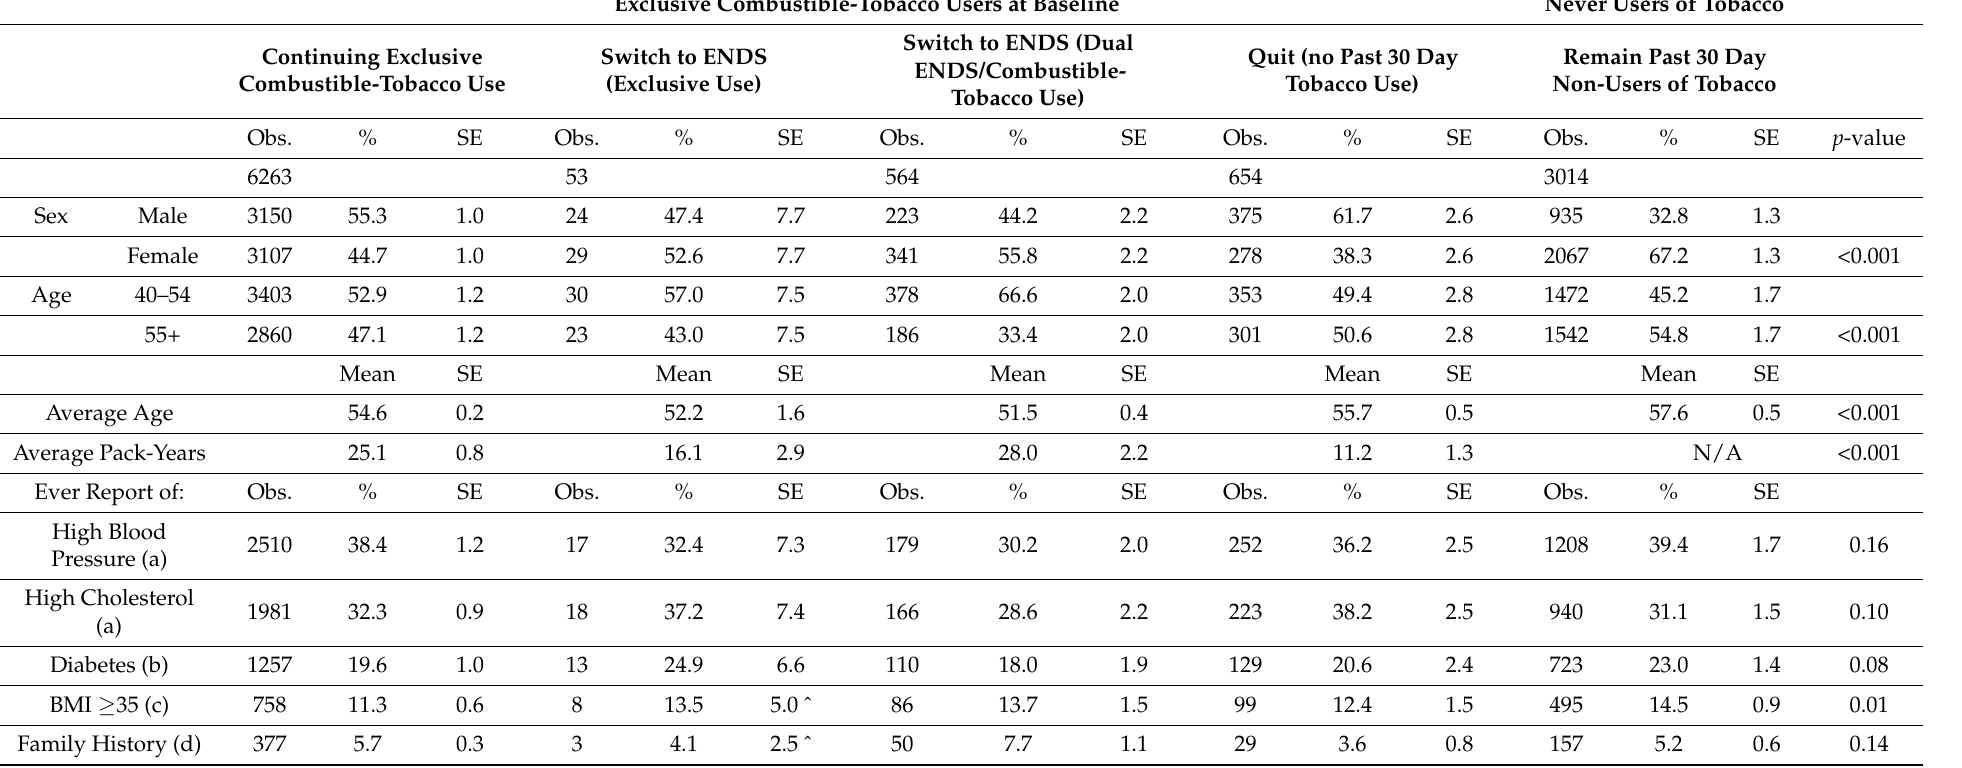
Table 1. Selected demographic and cardiovascular risk factors assessed at baseline, PATH Study adults age 40+ with no cardiac condition at baseline, by tobacco user group. Exclusive Combustible-Tobacco Users at Baseline Never Users of